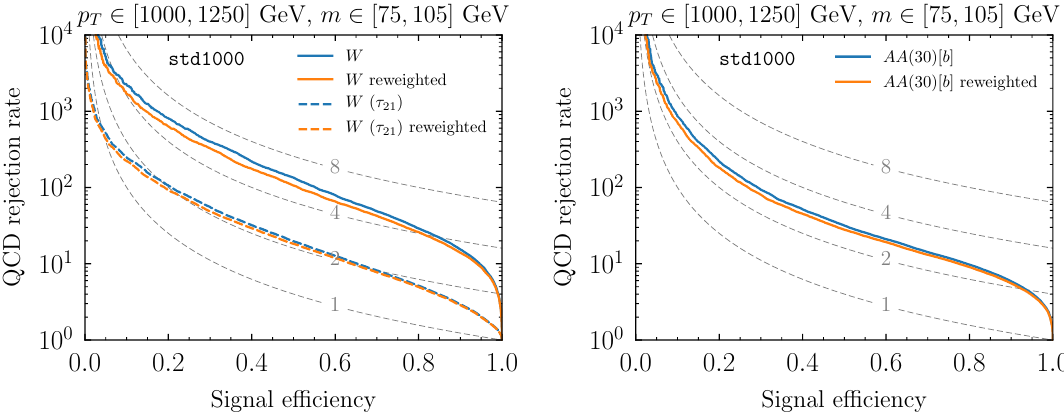
Figure 12 . Comparison between signal e(cid:14)ciency versus background rejection for W boson (left) and stealth boson (right) signals, with their original and with re-weighted p T J and m J distributions.